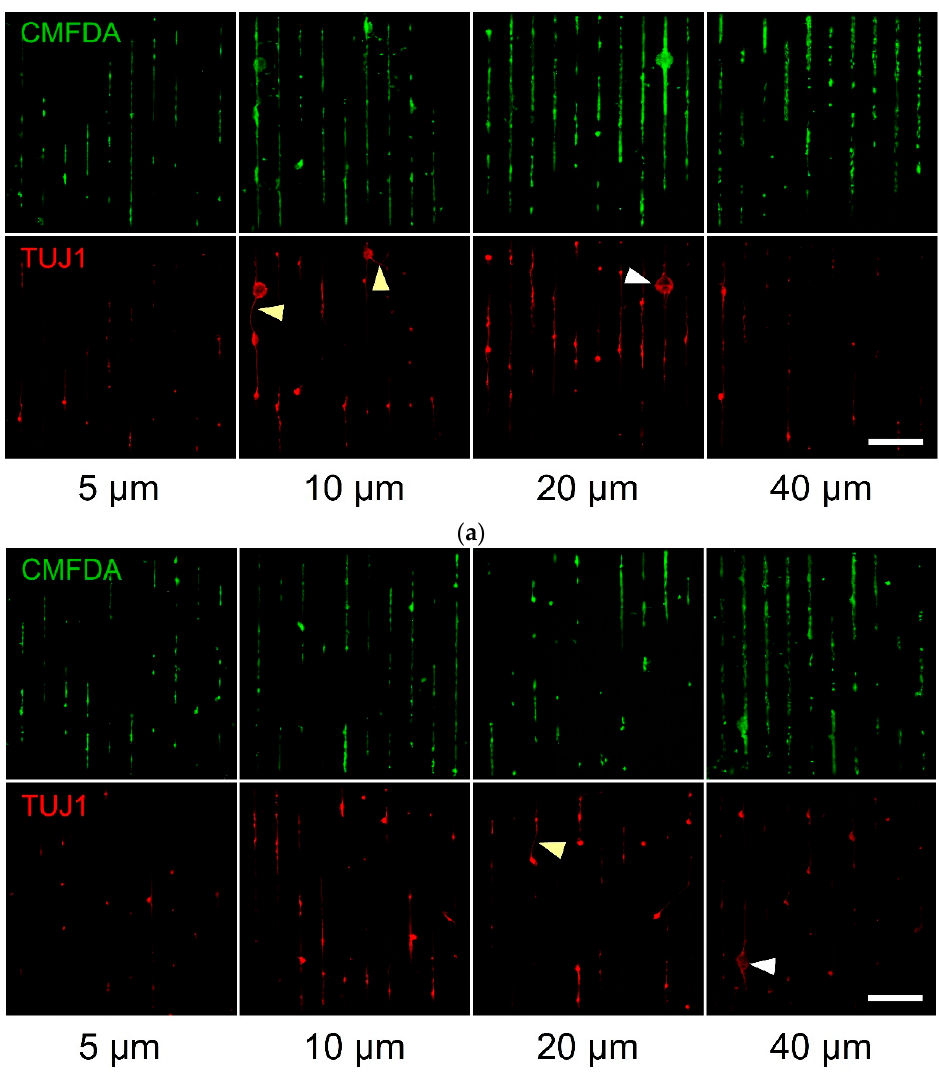
Figure 3. Patterned stem cell culture examples on parylene-C stripes of different geometries (width of parylene-C stripes below each column). The CMFDA dye (green channel) stained all the cells, whereas the TUJ1 antibody stained neuronal cells only (red channel): ( a ) patterns treated with serum and ( b ) untreated patterns. White arrowheads point to neuronal clusters and yellow arrowheads to extended neurites. Scale bar is 500 μ m.